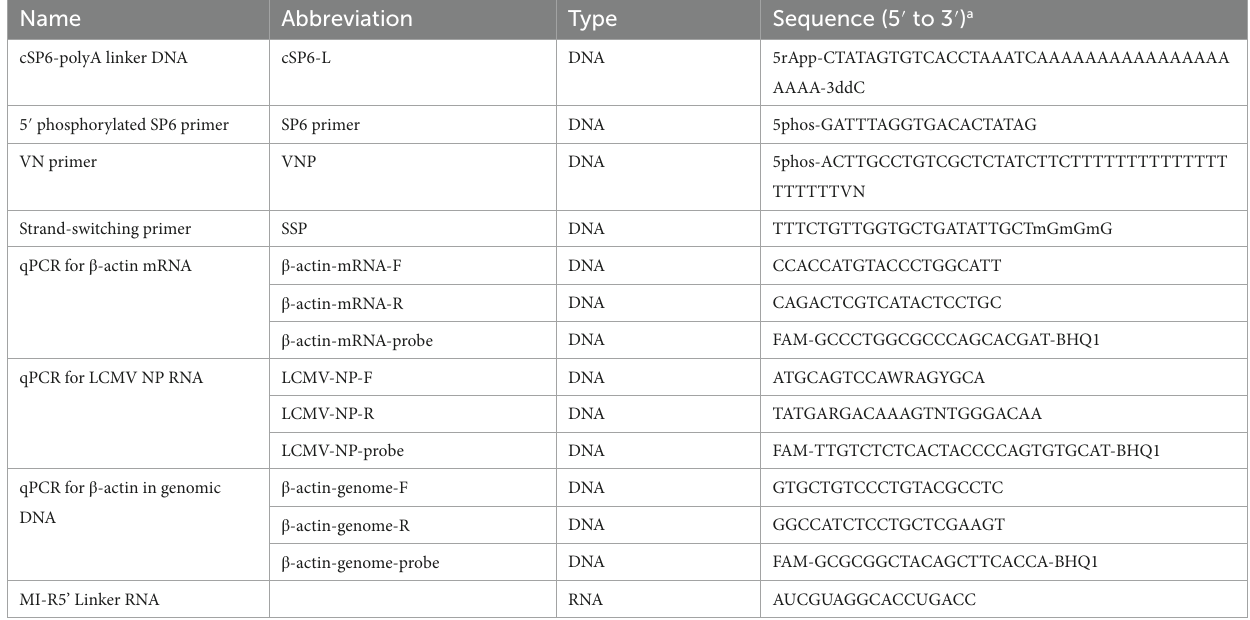
TABLE 1 List of linkers and primers used in this